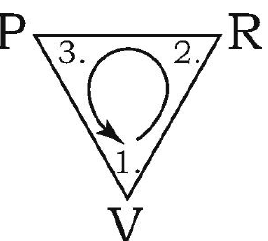
Figure 9: The Addiction Triangle k) Add Freudian dynamics